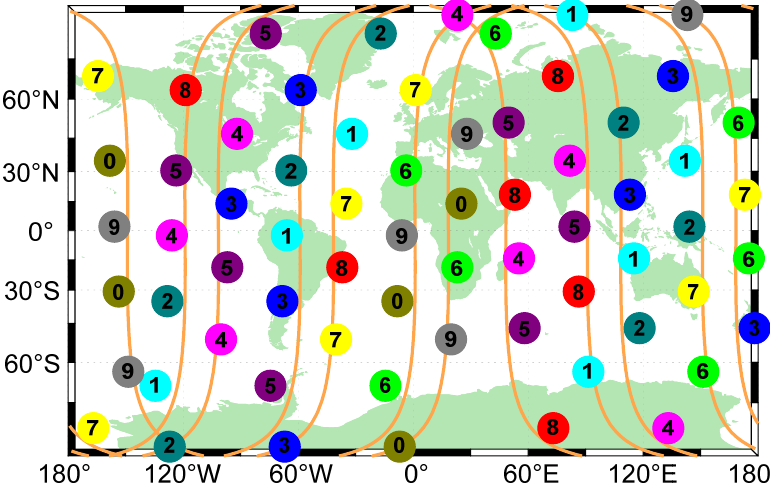
Figure 9. Graph of Iridium PRN code assignment. Ten colors and numbers represent ten PRN codes, which are enough to realize CDMA for Iridium constellation .